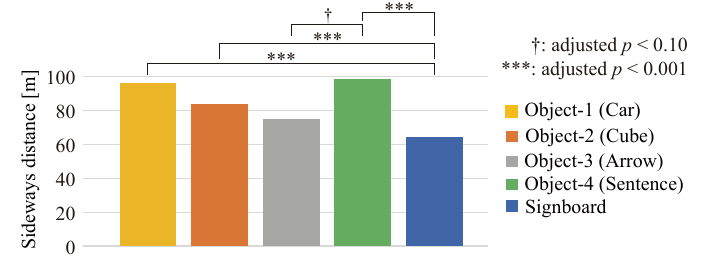
Figure 7. The average values of 4 m, 6 m, and 8 m points. Comparing Object-1 (that blends with the surroundings) with Object-2 (that does not match the surroundings), there is no difference between maximum values of the average.